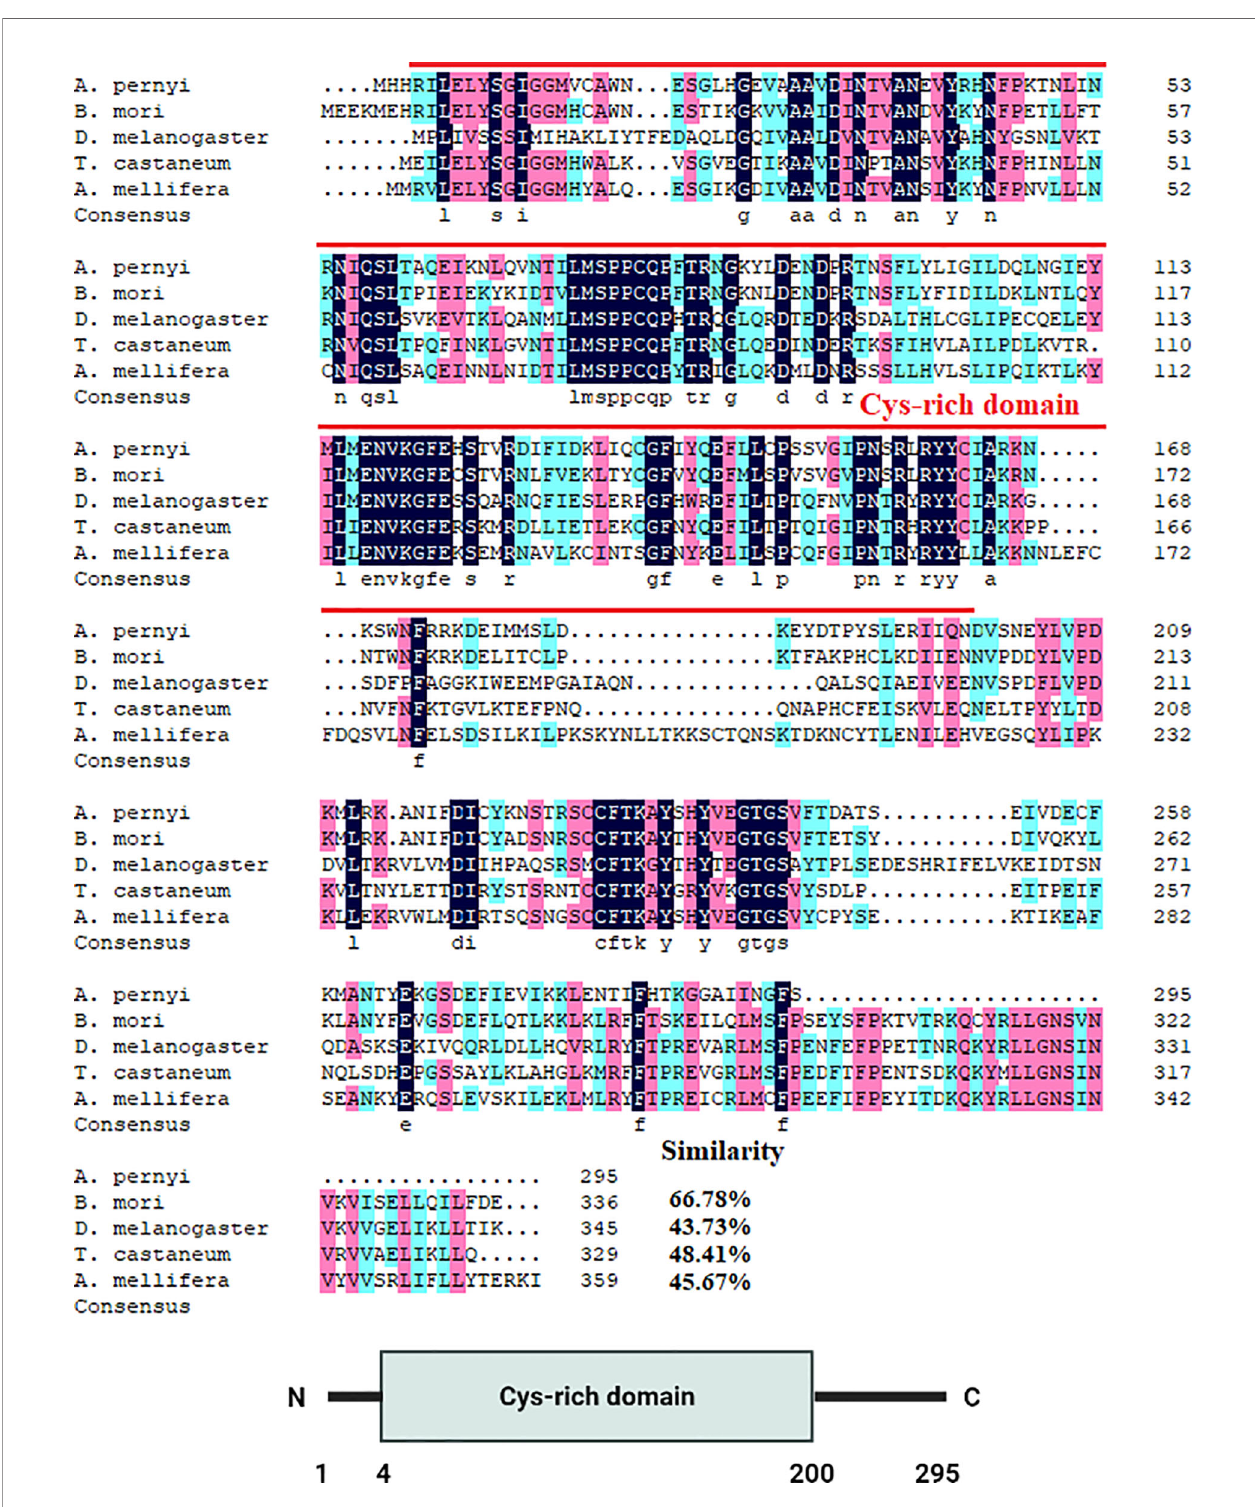
FIGURE 2 | Alignment of the ApDNMT-2 protein with homologous proteins. The ApDNMT-2 deduced amino acid sequence was aligned with other DNMT-2 protein sequences. The sequences for alignment analysis are the following: accession no. NP_001036934.1 ( Bombyx mori ), accession no. AAF03835.1 ( Drosophila melanogaster ), accession no. ( Tribolium castaneum ), accession no. XP_006563008.1 ( Apis mellifera ). The putative DNMT2 cyt_C5_DNA methylase superfamily domain is indicated by red